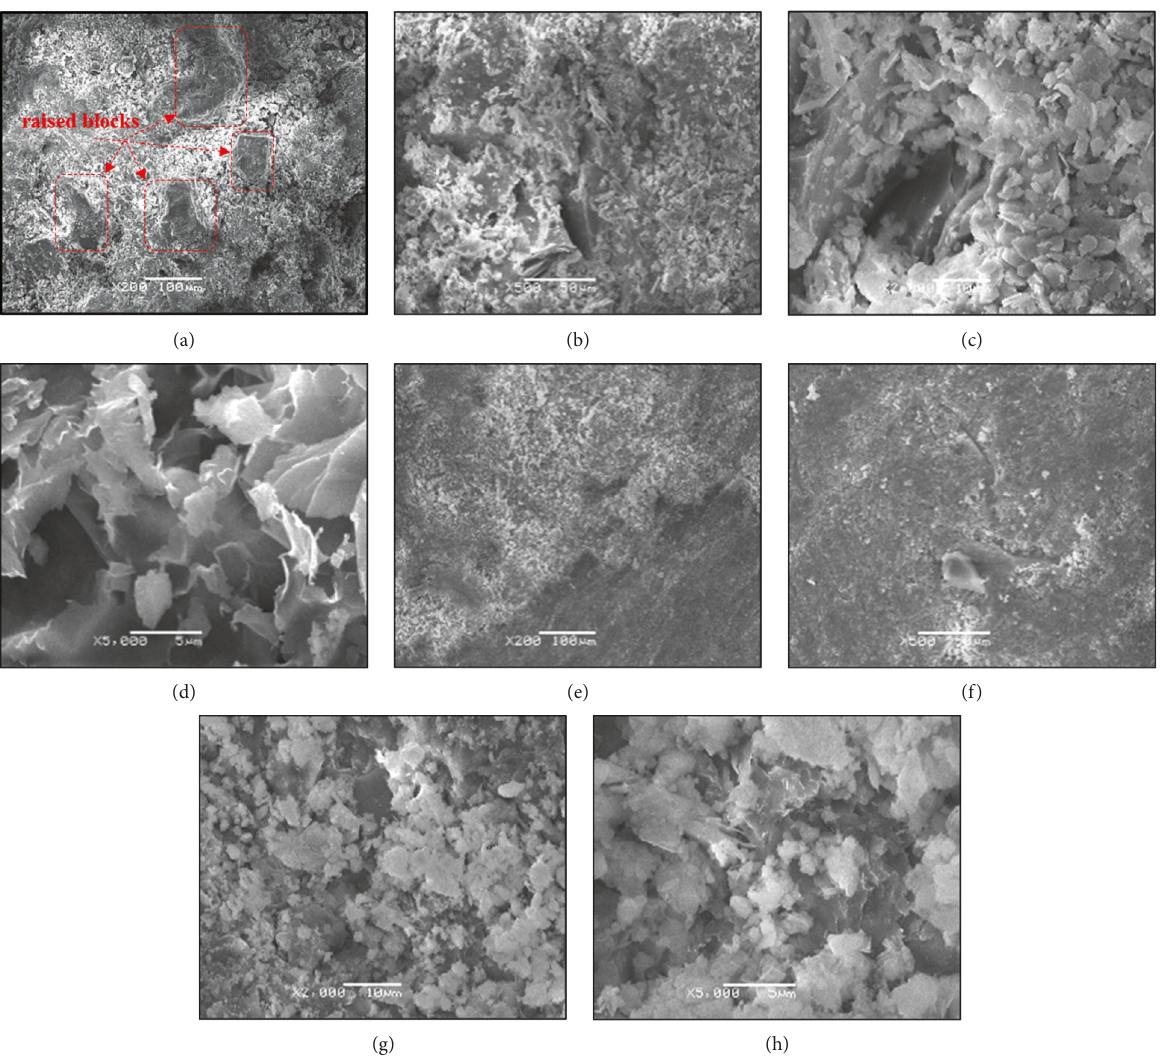
Figure 4: Scanning electron microscopy of mudstone and siltstone. (a) Mudstone magnification 200 times. (b) Mudstone magnification 500 times. (c) Mudstone magnification 2,000 times. (d) Mudstone magnification 5,000 times. (e) Siltstone magnified 200 times. (f) Siltstone magnified 500 times. (g) Siltstone magnified 2,000 times. (h) Siltstone magnified 5,000